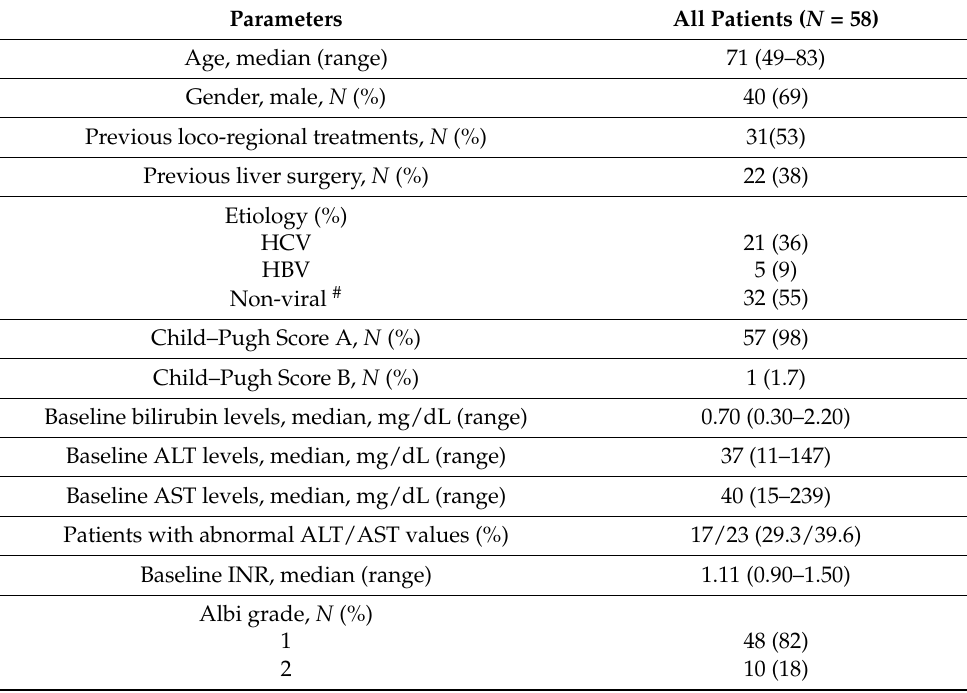
Table 1. Clinical characteristics of the studied patient